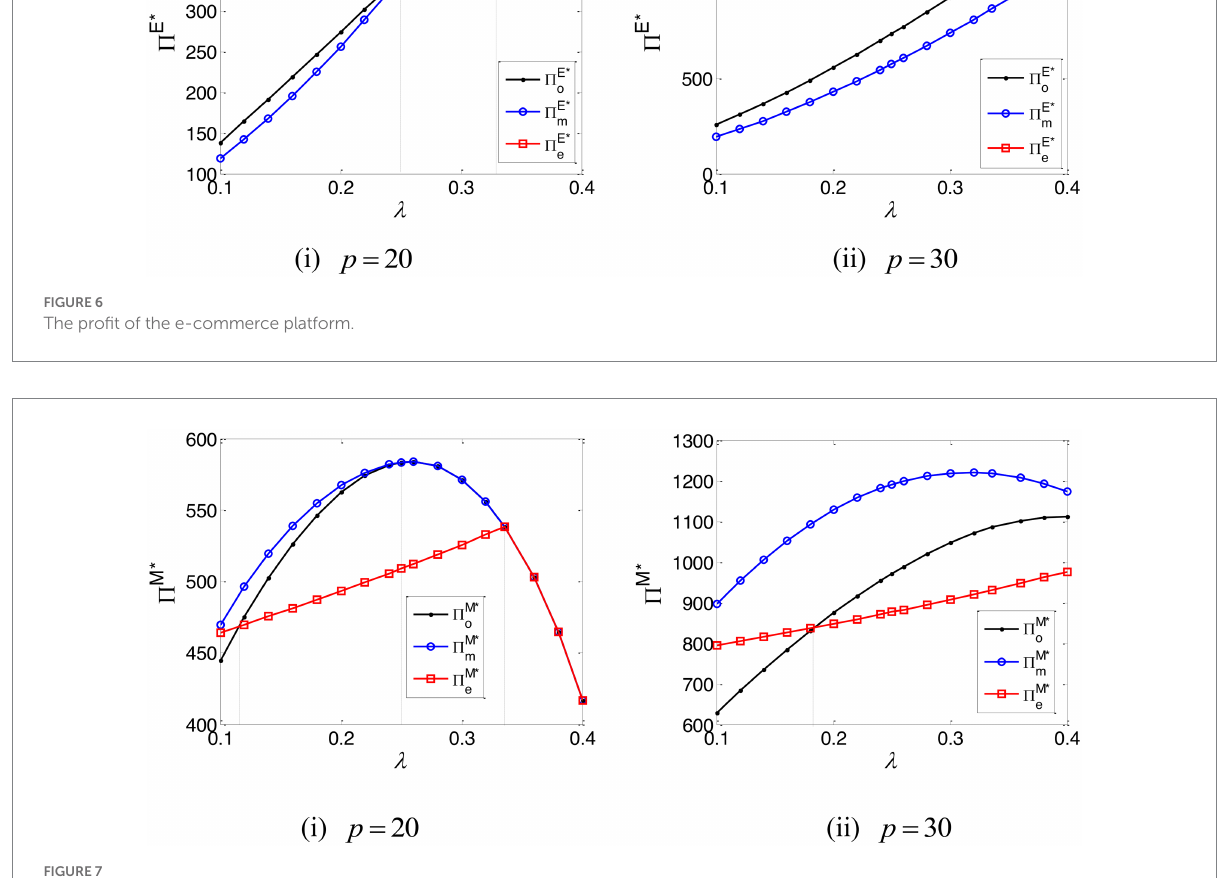
FIGURE 7 The profit of the